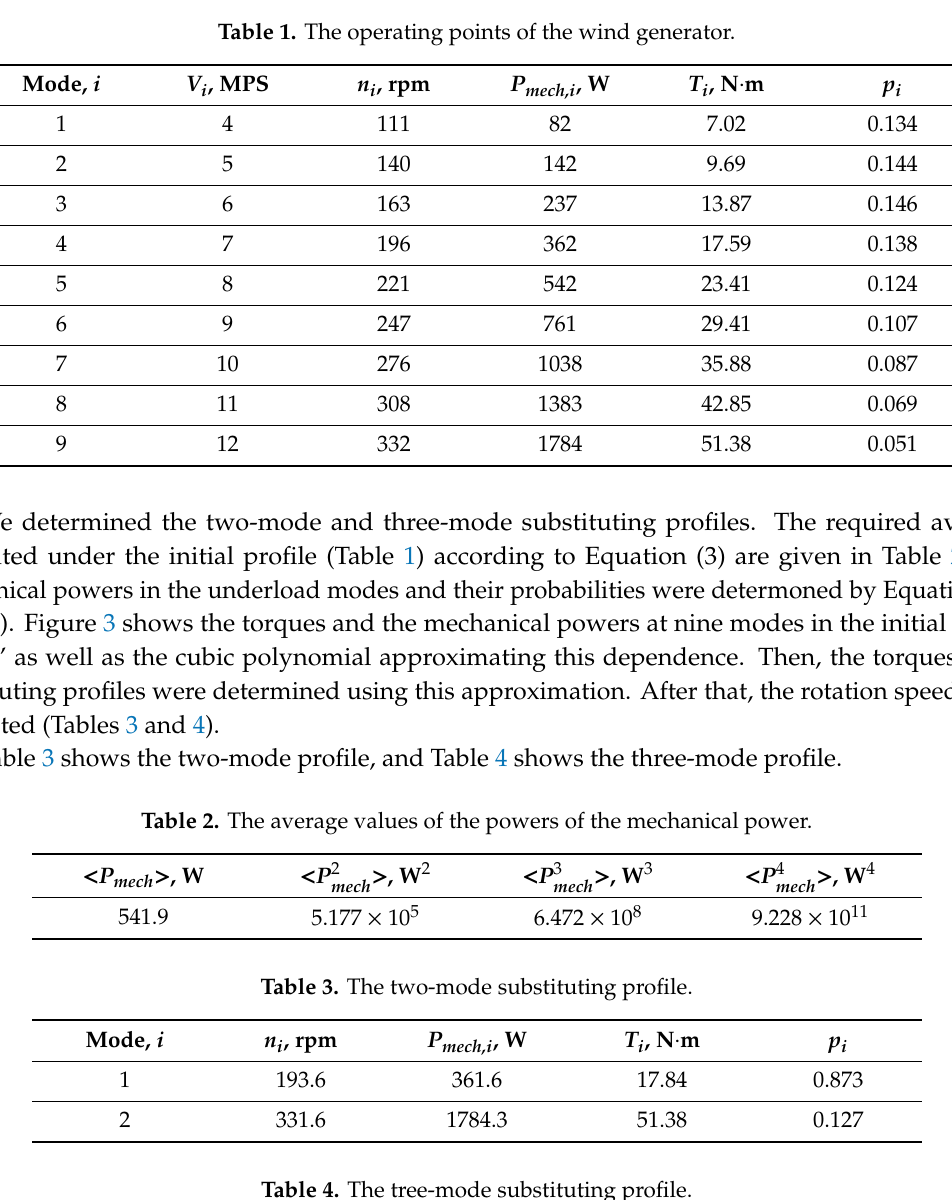
Table 4. The tree-mode substituting